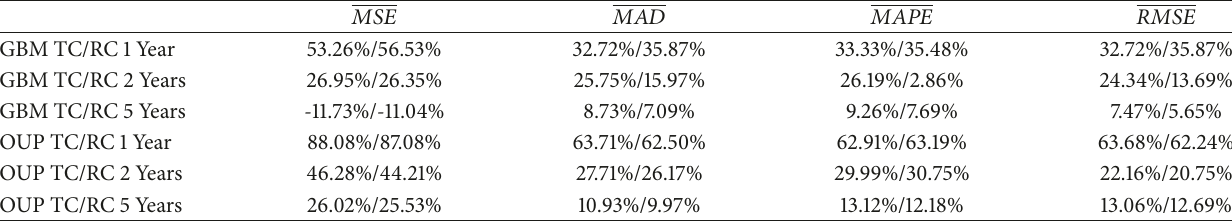
Table 14: Error Average Improvement for averaged monthly steps before annual steps.